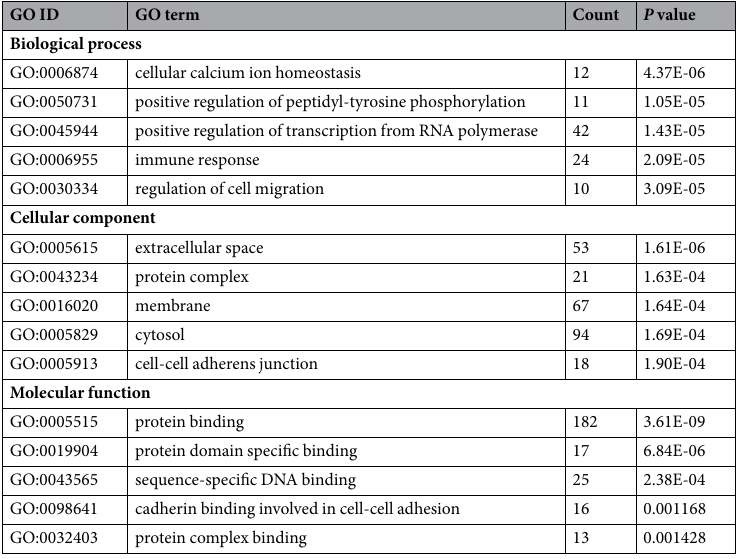
Table 3. The top 5 enrichment GO terms (BP, CC, and MF) of the co-expressed genes of HOXA11-AS. Note: GO, Gene Ontology.